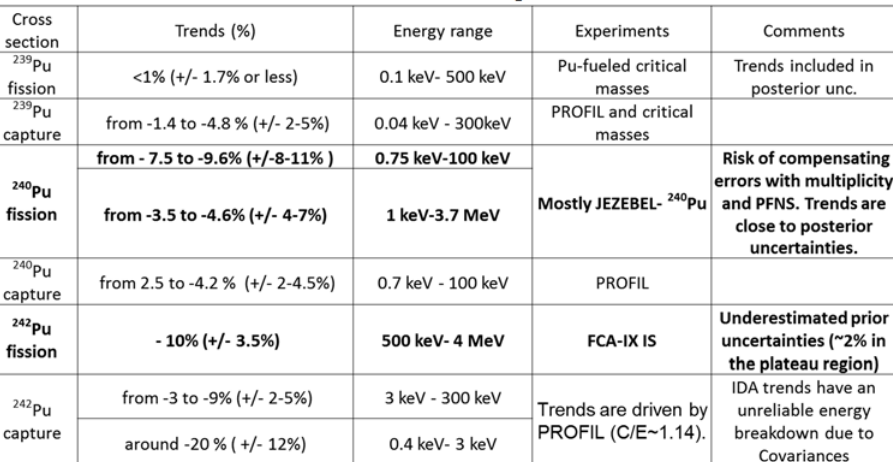
Table 2. Trends on Pu isotope cross